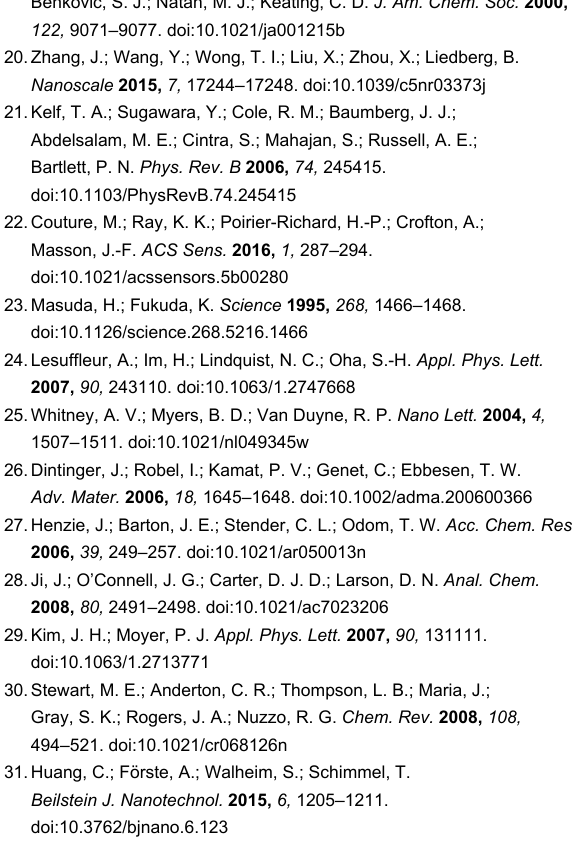
Figure S1: Respective size distribution analysis of the particles; Figure S2: Time dependence of the particle diameter reduction; Table S3: Fitting parameter for the interaction of DEP with rGO on various